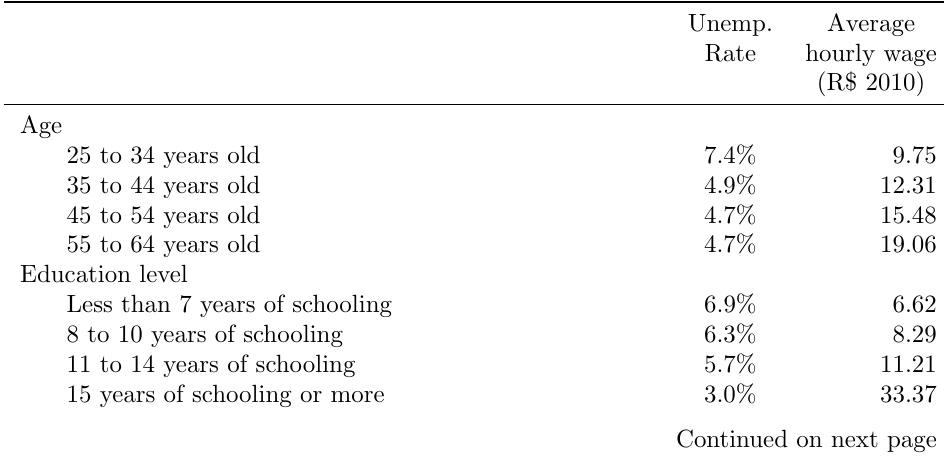
Table 3: Descriptive statistics by individual characteristics, 2010